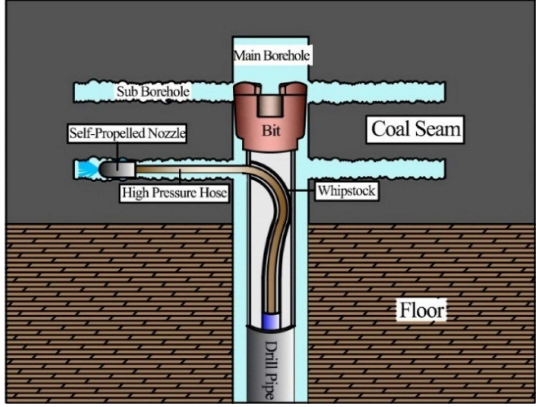
Figure 1. Schematic diagram of drilling to make tree-type boreholes in a coal